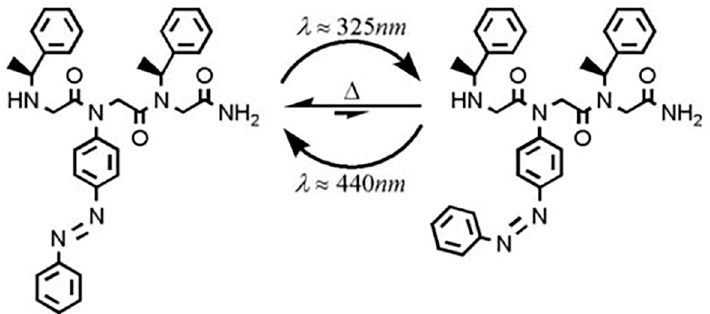
Figure 11. Photoisomerization and thermal back-isomerization of azobenzene peptoid. Reprinted with permission from [94]. Copyright 2008, Royal Society of Chemistry.